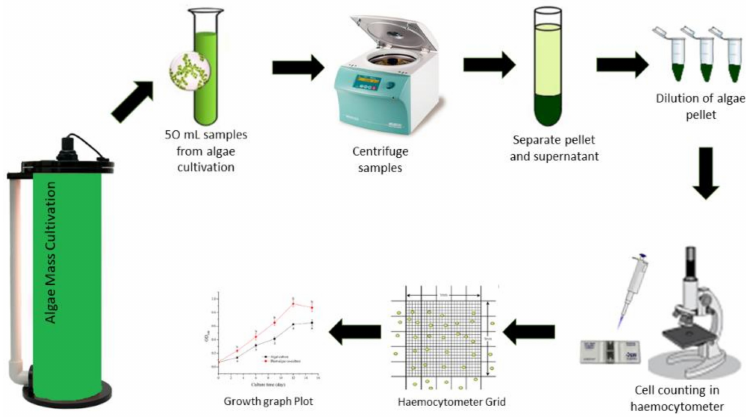
Figure 1. Microalgae cell counting for growth rate